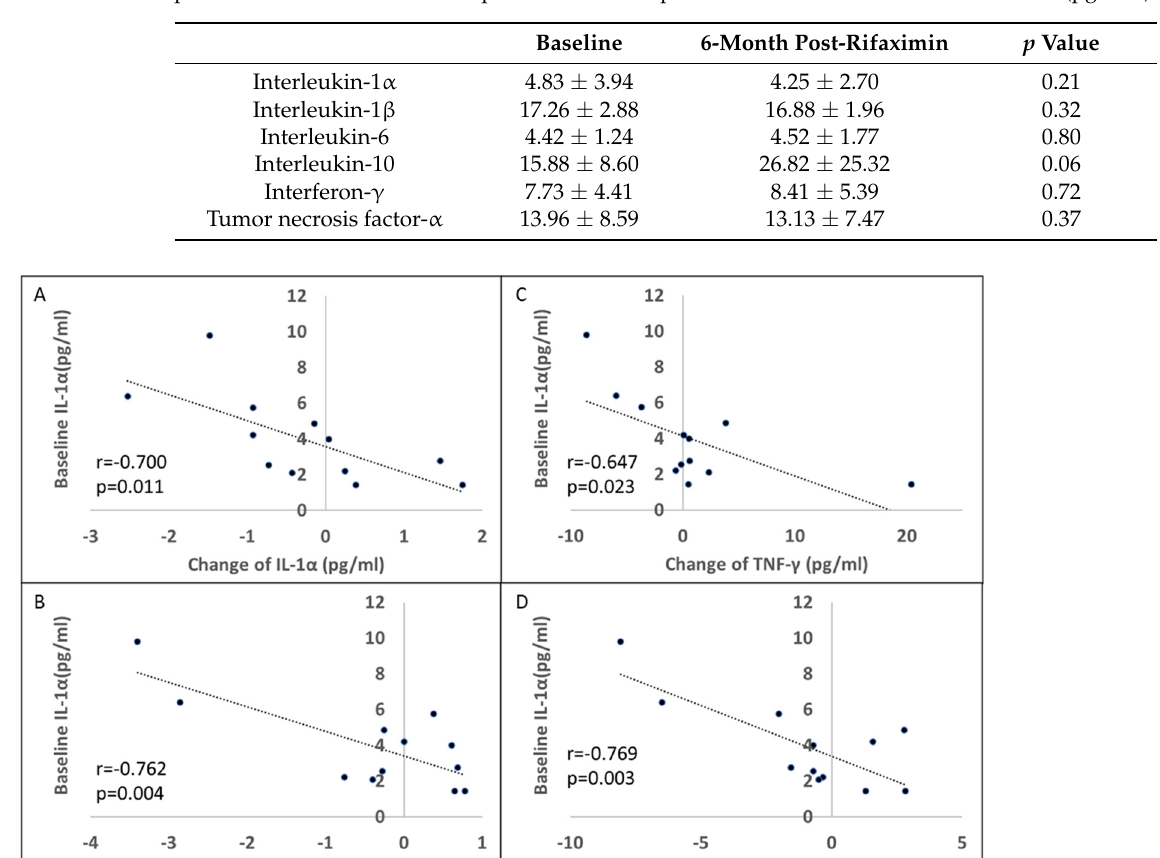
Table 2. Serum Cytokine profile. The change in serum cytokine level between baseline and 6-month post-rifaximin treatment in PD patients. Data are presented as mean ± standard deviation (pg/mL).